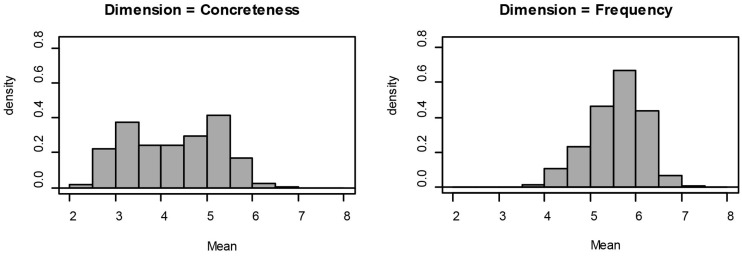
Distribution of Concreteness and Frequency ratings.